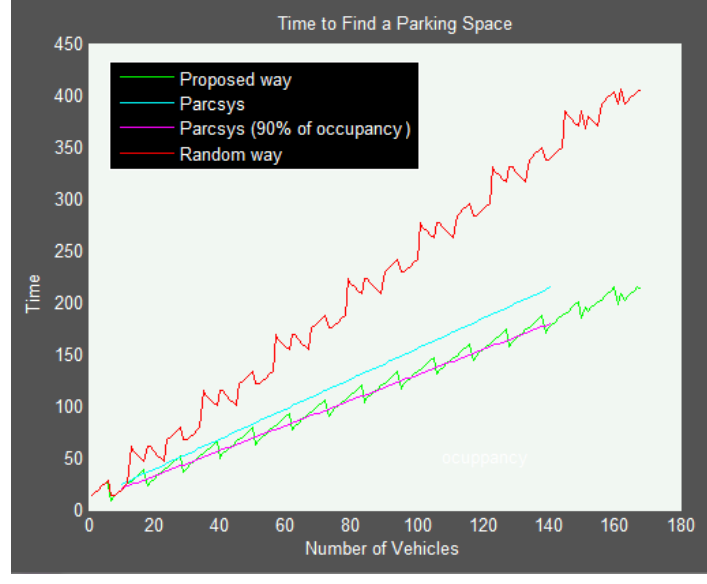
Figure 12. Comparative